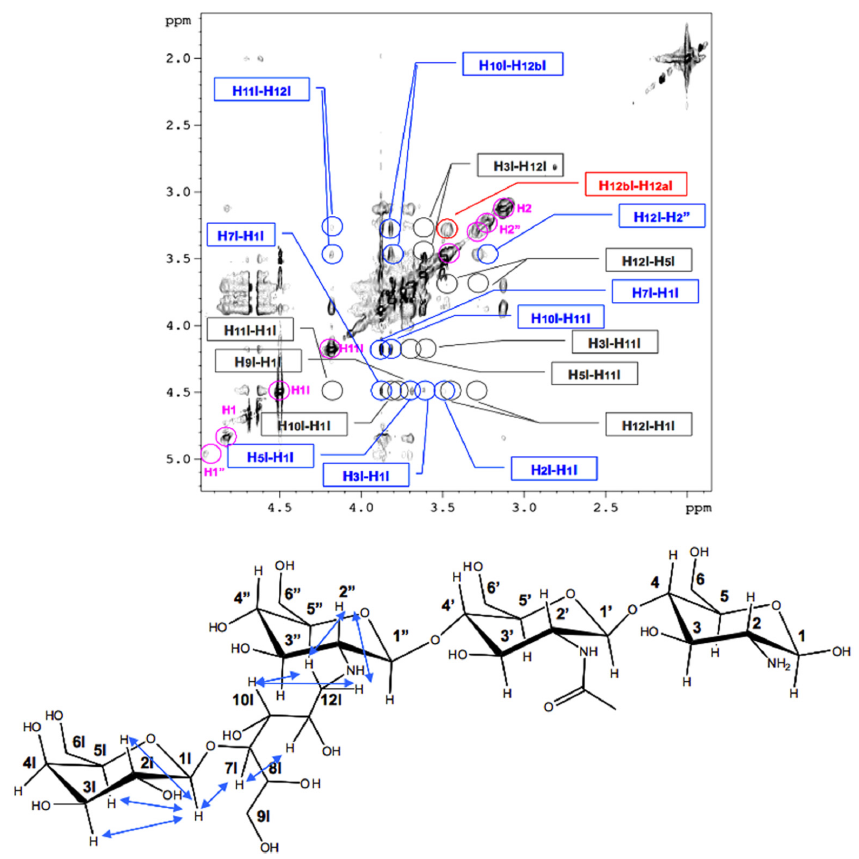
Figure 2. (Top) 1 H, 1 H-2D NOESY spectrum of lactose-modified chitosan in D 2 O. Unambiguous meaningful NOEs are shown in blue. Empty regions indicating the absence of NOE between two protons are shown in dark gray; the NOE peak used for distance calibration connecting H12 geminal protons (distinguished with letters a and b) are shown in red. Other diagonal peaks are shown in magenta. (Bottom) NOE network regarding the lactitol moiety is shown on the polysaccharide structure. Reprinted with permission from Phys. Chem. B 2013, 117, 43, 13578-13587. Copyright (2013) American Chemical Society.